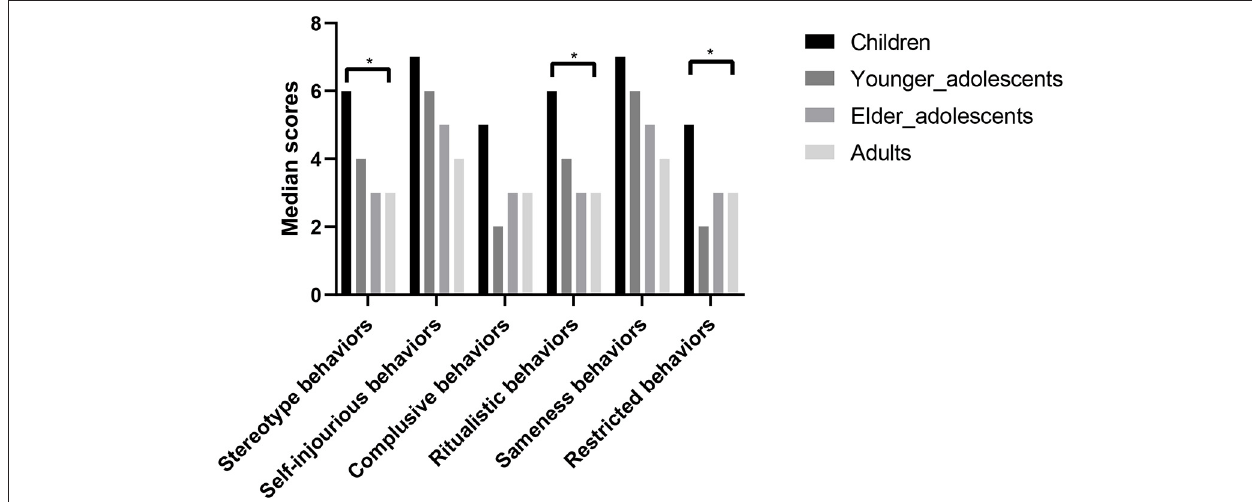
FIGURE 1 | RRBI subtype scores at different developmental stages ( n = 147). Median scores are shown for six subtypes of RRBIs (stereotyped behaviors, self-injurious behaviors, compulsive behaviors, ritualistic behaviors, sameness behaviors, and restricted behaviors) in four age groups: children (6–9 years old),